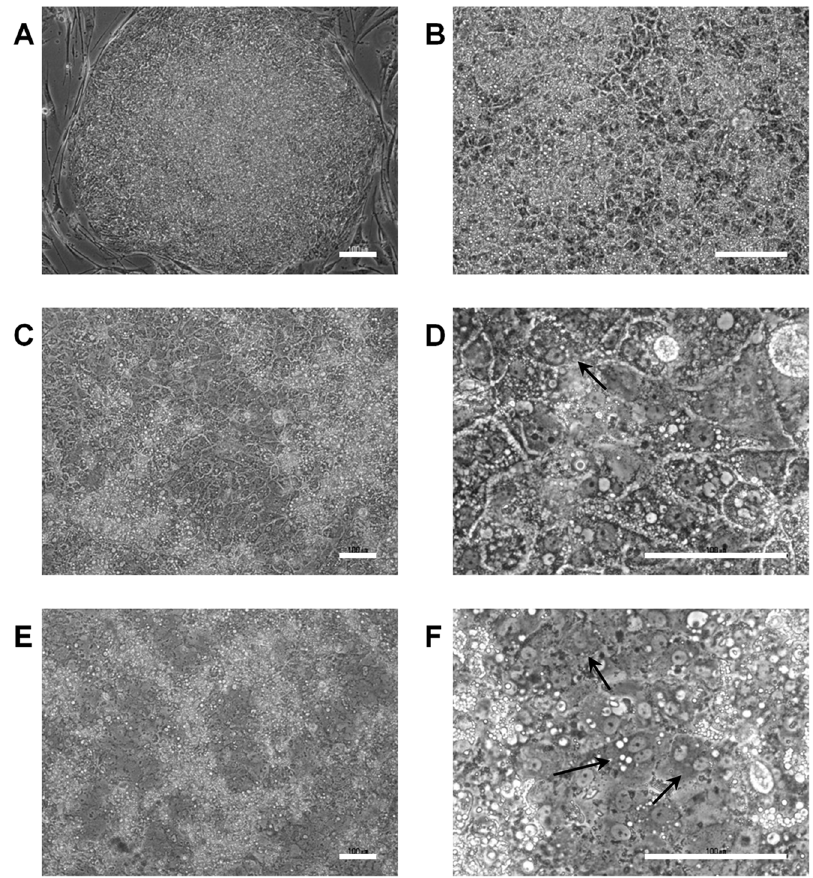
Figure 3. Morphological changes observed in hiPS cells during hepatic differentiation. The images show morphological changes in human iPS (hiPS) cells (Windy). (A) Undifferentiated hiPS cells; (B) hepatic progenitor cell-like cells after 12 days of differentiation; (C, D) hepatocyte- like cells after 25 days of differentiation in the absence of valproic acid (VPA); and (E, F) hepatocyte-like cells after 25 days of differentiation in the presence of 2-mM VPA for 168 h from day 12. Arrows indicate binuclear cells. Scale bar, 100 m m.